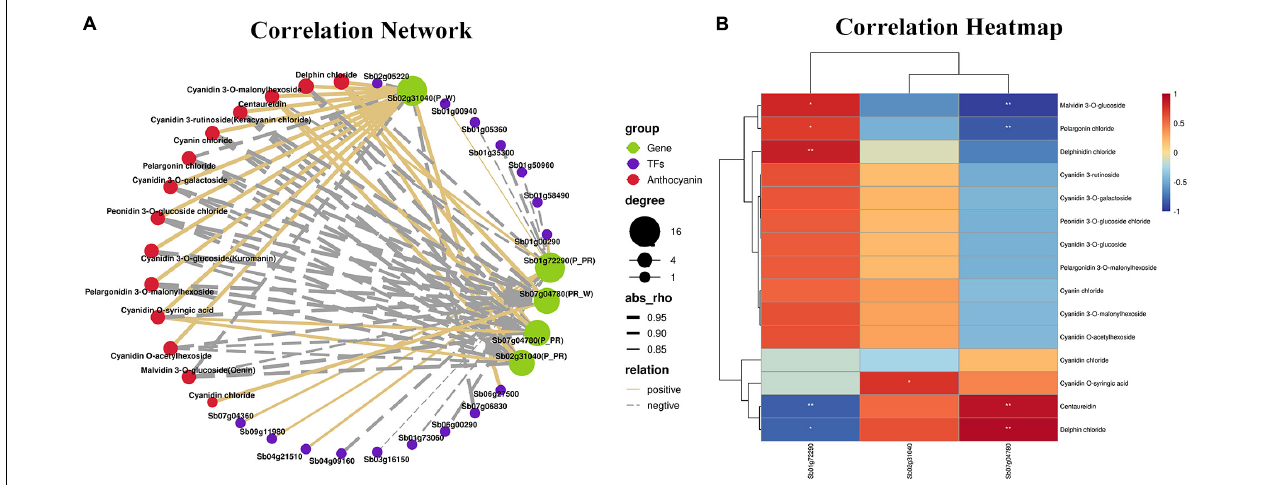
FIGURE 5 | Connection network between metabolite and transcriptome profiles. (A) Connection networks among DEGs, TFs, and anthocyanin metabolites. The red, green, and blue colors represents anthocyanin metabolites, DEGs and TFs, respectively. The solid and dotted lines represent positive and negative correlations, respectively. Line width represents the degree of correlation. (B) Correlation heatmap of three DEGs in the anthocyanin synthesis pathway and 15 anthocyanins among the three different-colored flowers of Scutellaria baicalensis . The heatmap was constructed according to the FPKM value. The red and blue represent positive and negative correlations,